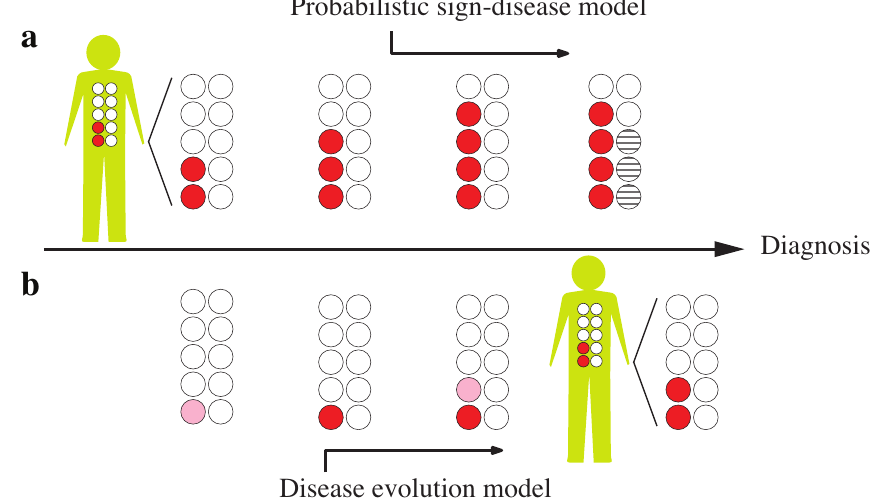
Figure 1. Uncovering (learning) macroscopic features (diagnosis) from microscopic sign variables: ( a ) using a powerful probabilistic model for a selective observation of additional signs and a careful anticipation of a few other sign values by simulating the diagnostic process; ( b ) using a microscopic model of disease evolution to estimate the likelihood of a disease hypothesis from the history (dynamics) of the observed signs. Here, empty circles indicate the unobserved signs, the filled circles are the observed signs with possibly different levels of activity, and the dashed circles show the anticipated sign